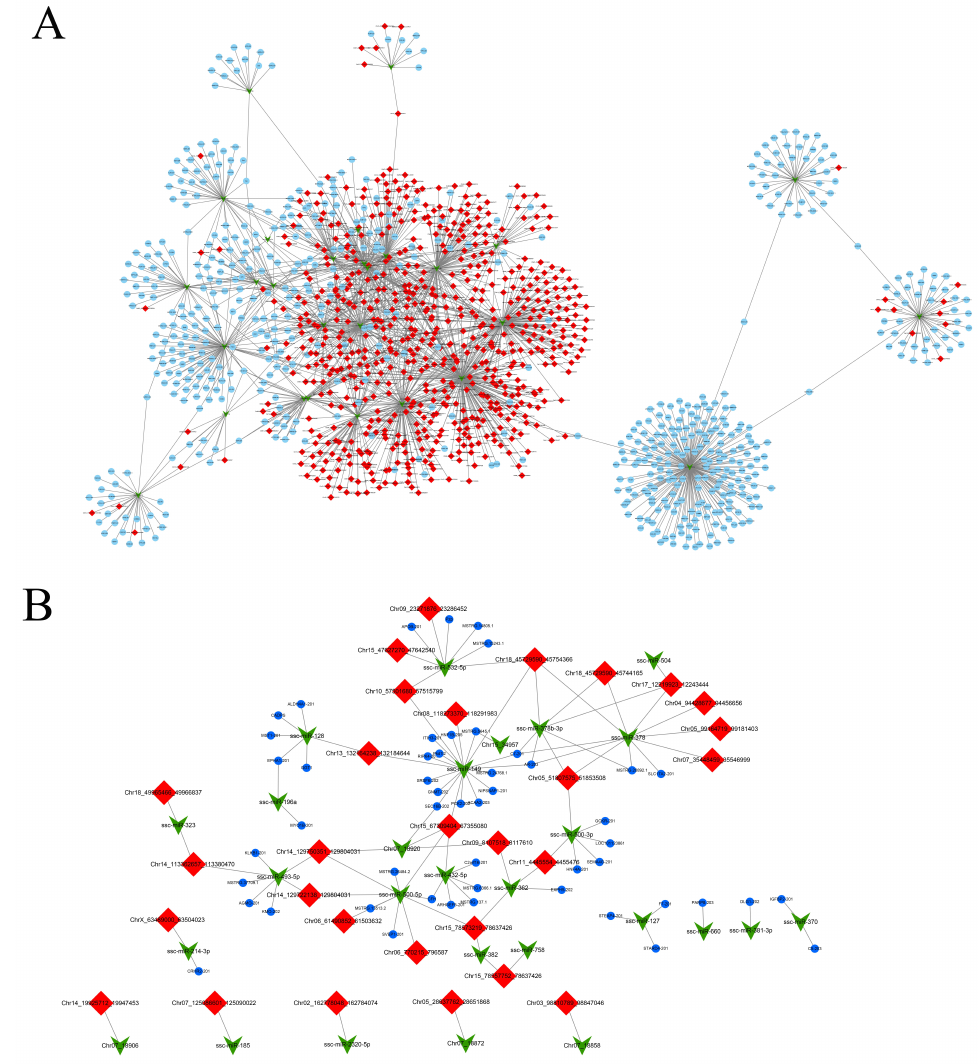
Figure 4. A view of interaction among circRNAs–miRNAs–mRNAs in liver: ( A ) mRNAs were associated with miRNA profile 4 and circRNA profile 21 to obtain the ceRNA regulation network; ( B ) red diamond nodes represent circRNAs; blue circle nodes represent mRNAs; green arrow nodes represent